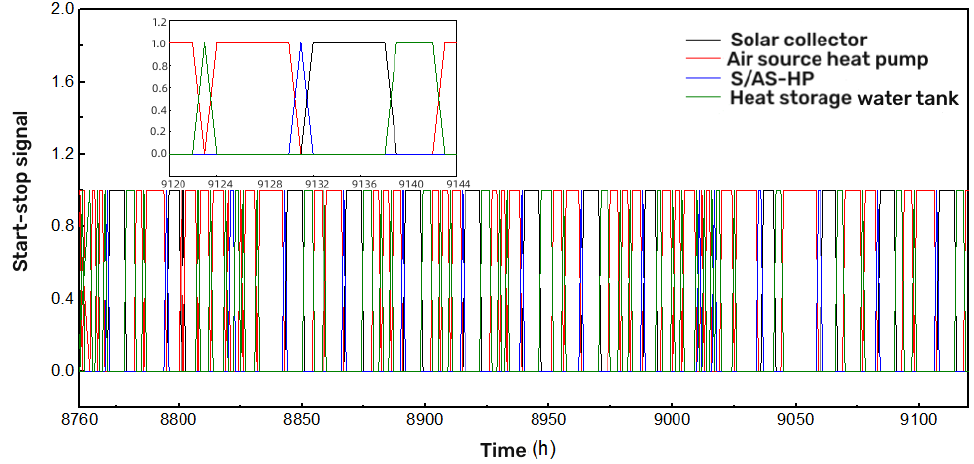
Figure 5. System hourly start/stop signals for different heating modes in January.